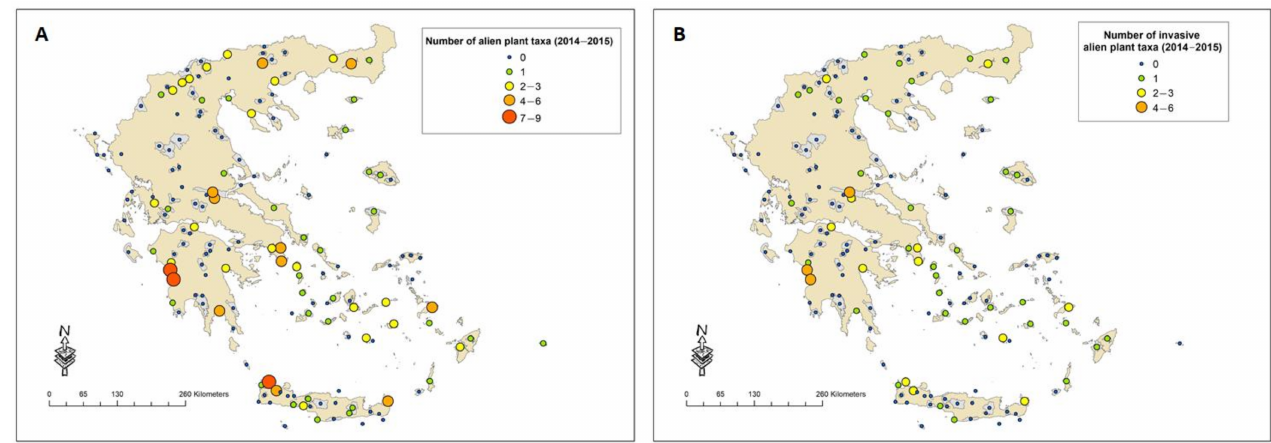
Figure 2. Number of alien plant ( A ) and IAPS ( B ) recorded in each site during period B